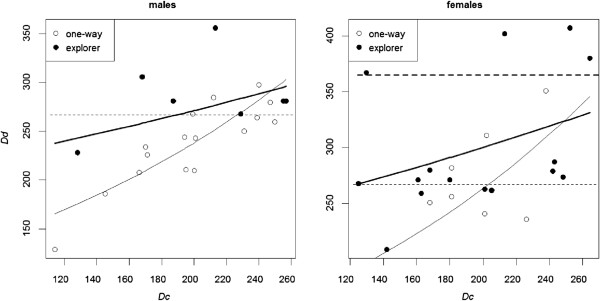
Date of departure (Dd) for juvenile ‘One-way’ dispersers (open circles) and date of first foray departure for juvenile ‘Explorer’ (full circles) according to sex and date of capture (Dc). The date is the number of days since the beginning of the birth year for each hare. Solid lines are back-transformed predictions for ‘One-way’ departures (thin lines) and for ‘Explorer’ departures (thick line). Dashed lines show the beginning (thin) and the end (bold) of the hare hunting period.